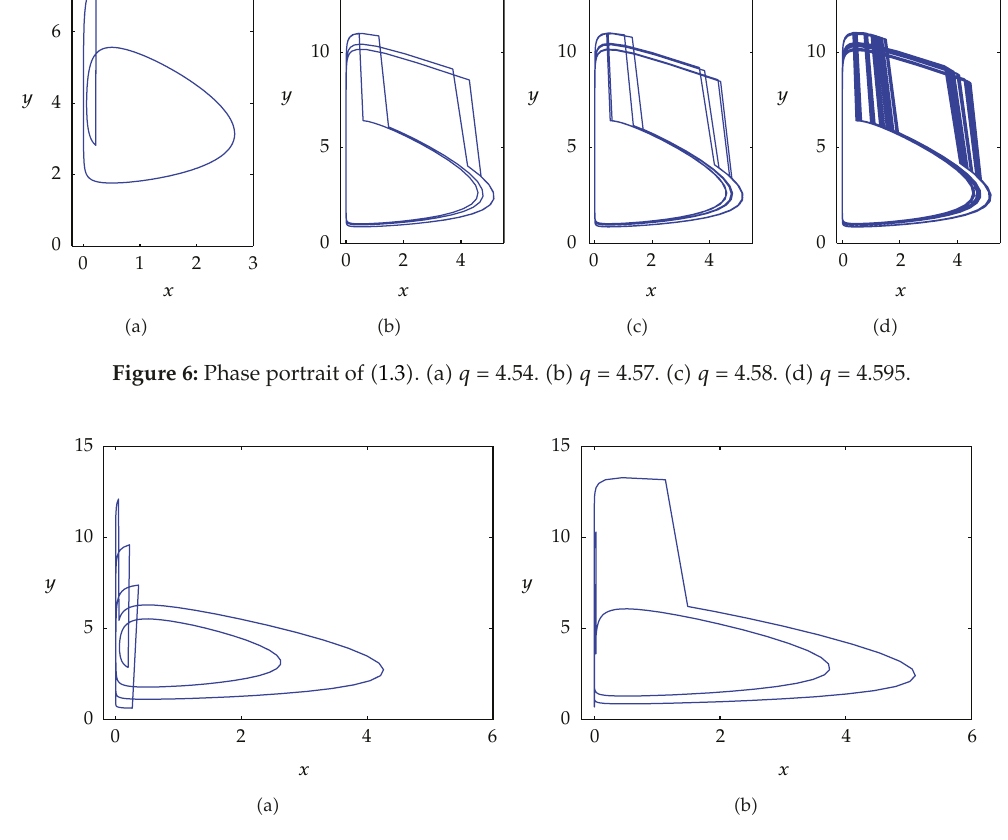
Figure 7: Coexistence of solutions when p (cid:6) 6 . 755. (cid:3) a (cid:4) Solution with initial values (cid:3) 1 , 1 (cid:4) . (cid:3) b (cid:4) Solution with initial values (cid:3) 1 . 3 , 2 . 9 (cid:4) .